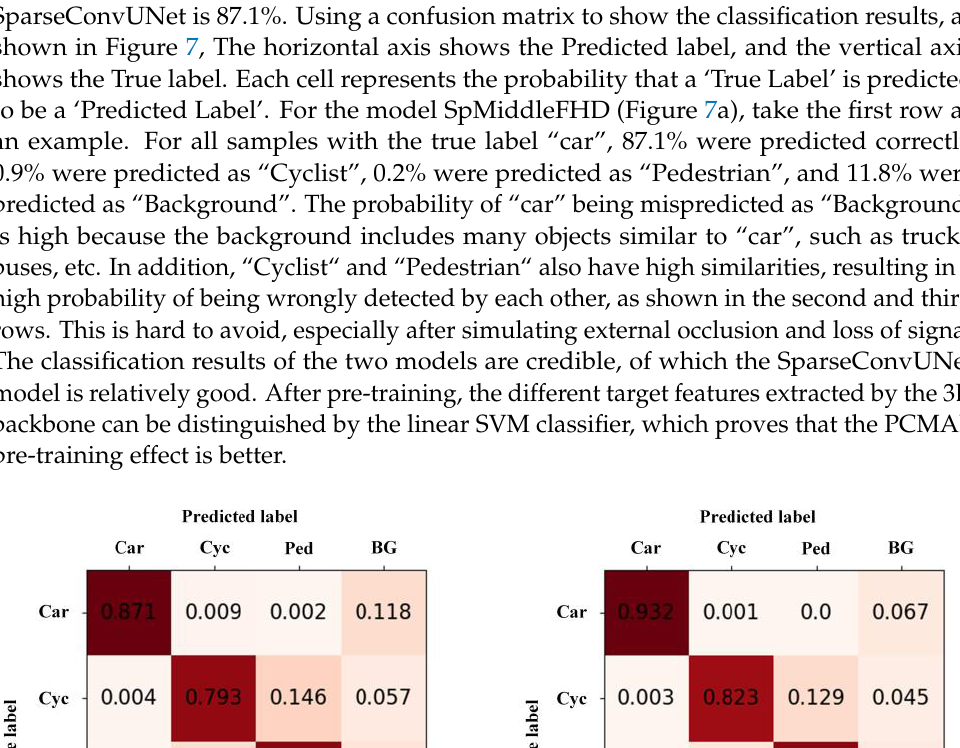
8 of 15 Figure 6. Pre-training flow. ( a ) Training phase. ( b ) Validation phase. In the training phase, PCMAE is based on PyTorch [33], and both 3D backbones are trained with the same configuration and parameters. The models are optimized with an AdamW [34] optimizer with β1 = 0.9 and β2 = 0.999. The network trained with a batch size of 16 on two NVIDIA Quadro RTX 6000 GPUs. Initial learning rate as 5 × 10 −4 and weight decay as 1 × 10 −3 . The optimization is set to stop after 160 epochs.